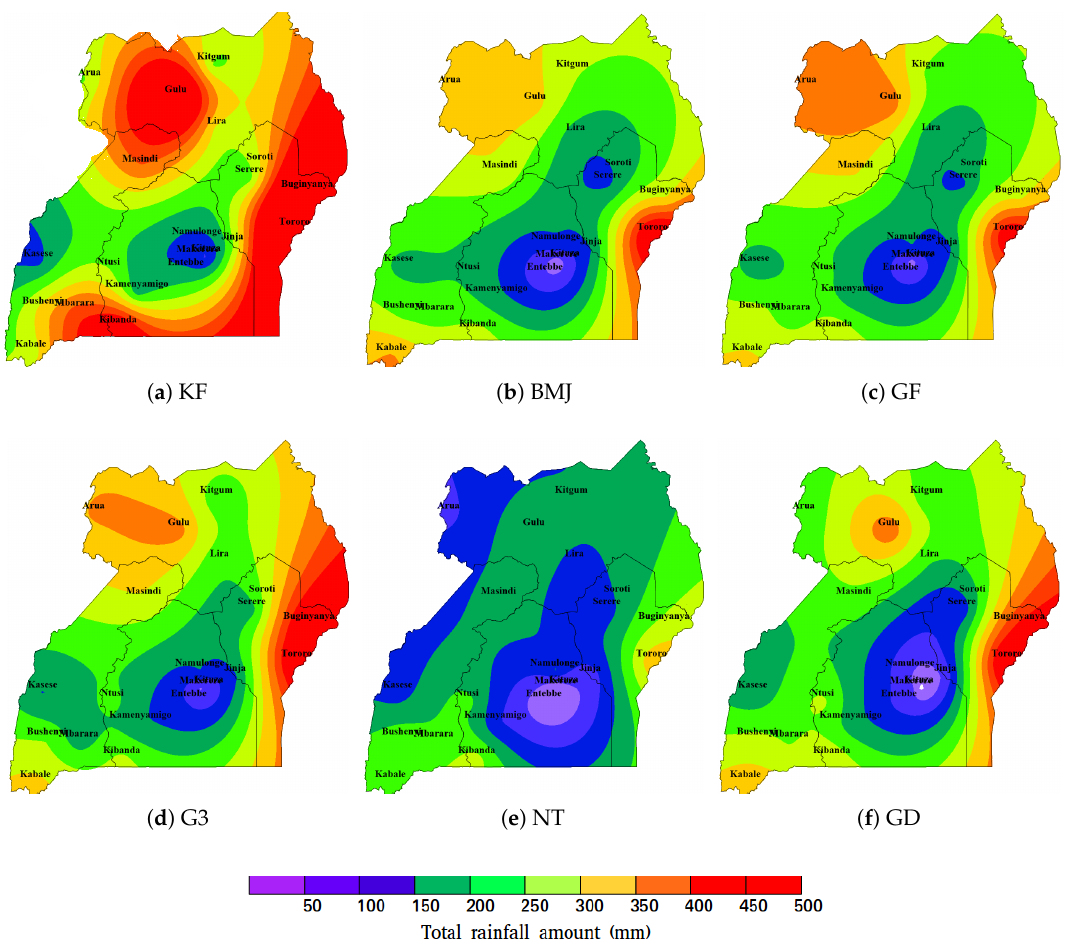
Figure 3. Shows the spatially interpolated total amount of rainfall simulated by the cumulus parameterization schemes for the MAM 2013 rainfall period using